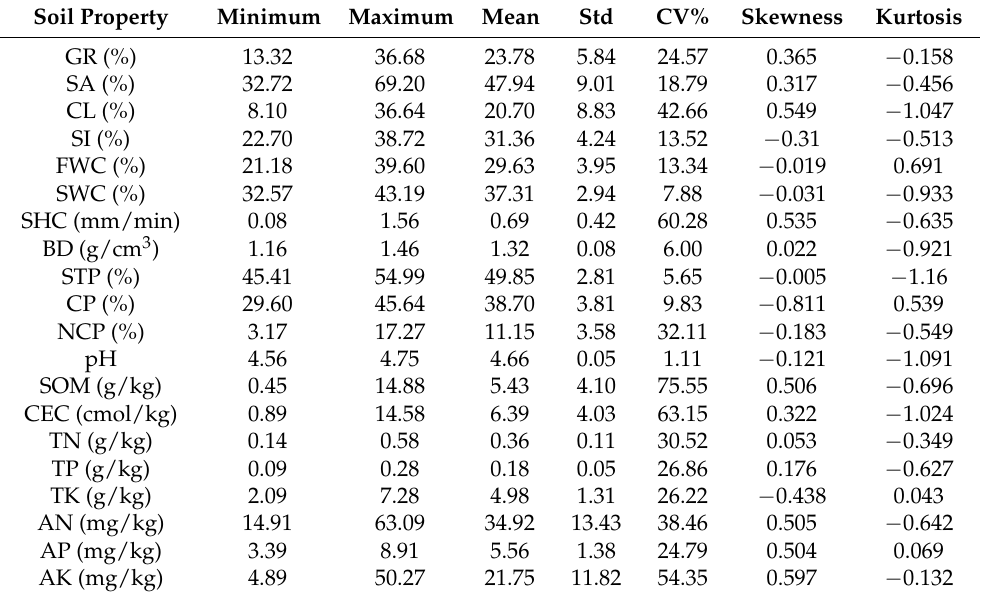
Table 1. Statistical characteristic values of soil physical and chemical properties in the study area. Soil Property Minimum Maximum